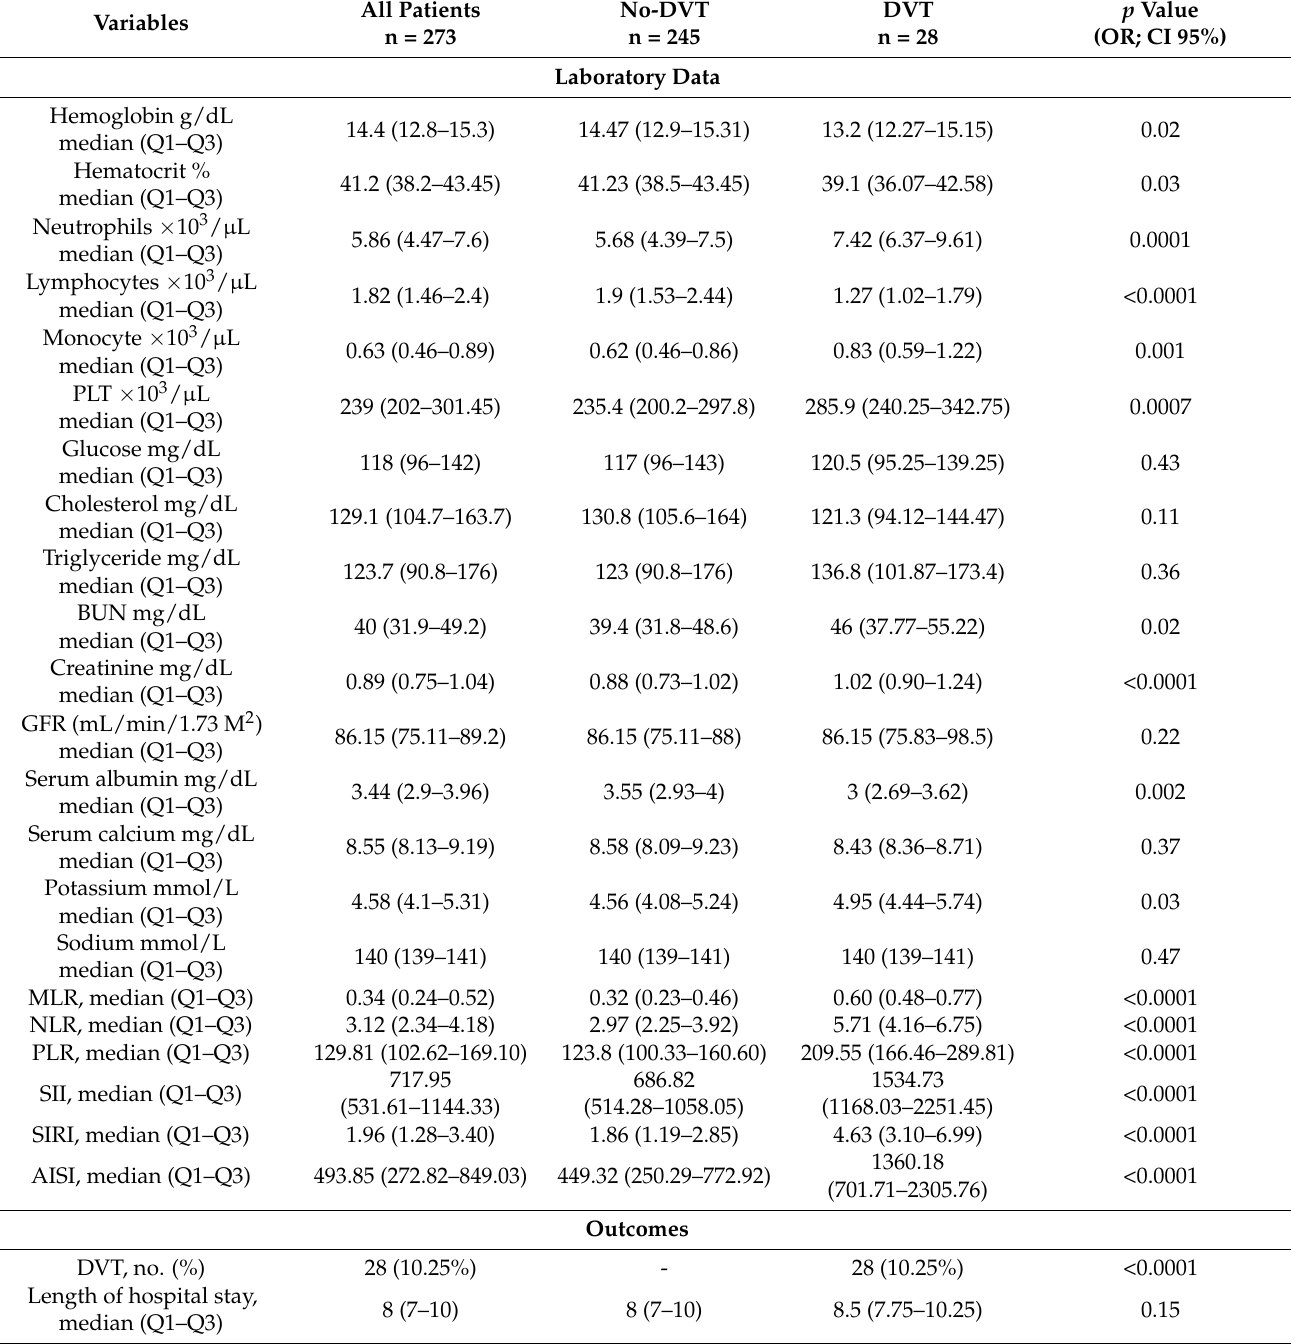
(Figure 1). The optimal cut-off value obtained from Youden’s index, areas under the curve (AUC), and the predictive accuracy of the markers are listed in Table